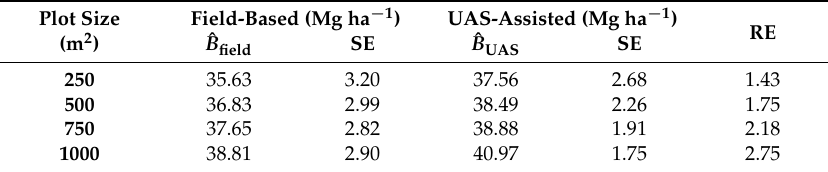
Table 5. Estimated mean AGB and associated standard error (SE) estimates based on field-based and UAS-assisted estimation for different sample plot sizes.